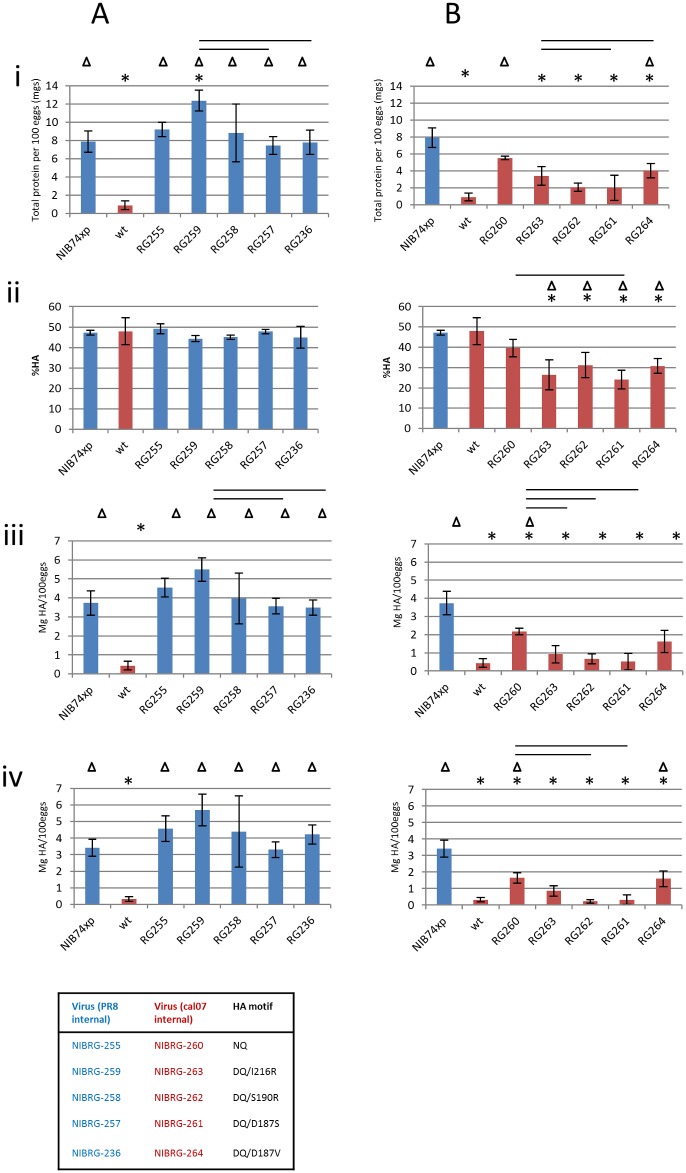
Yield analysis of viruses.Panel A shows data for viruses with PR8 internal genes (in blue) compared to Chr/16 wt (in red). Panel B shows data for viruses with A(H1N1)pdm09 internal genes (in red) compared to NIB-74xp (in blue). In each panel the asterisks (*) denote statistically significant differences to NIB-74xp (p<0.05), and a triangle (Δ) denotes a statistically significant difference to Chr/16 wt (p<0.05). The black bars denote statistically significant differences (p<0.05) between the other viruses. (i) Total protein yield for each virus measured by BCA assay. (ii) HA content of each virus, expressed as percentage HA relative to the total of the four major viral protein bands (HA1, HA2, NP, M1), as measured by SDS-PAGE analysis. (iii) Average yield of total HA protein calculated from percentage HA and total protein concentration data. (iv) Average yield of HA as measured by SRD assay. All data are the average of at least three independent experiments and error bars denote standard deviation.